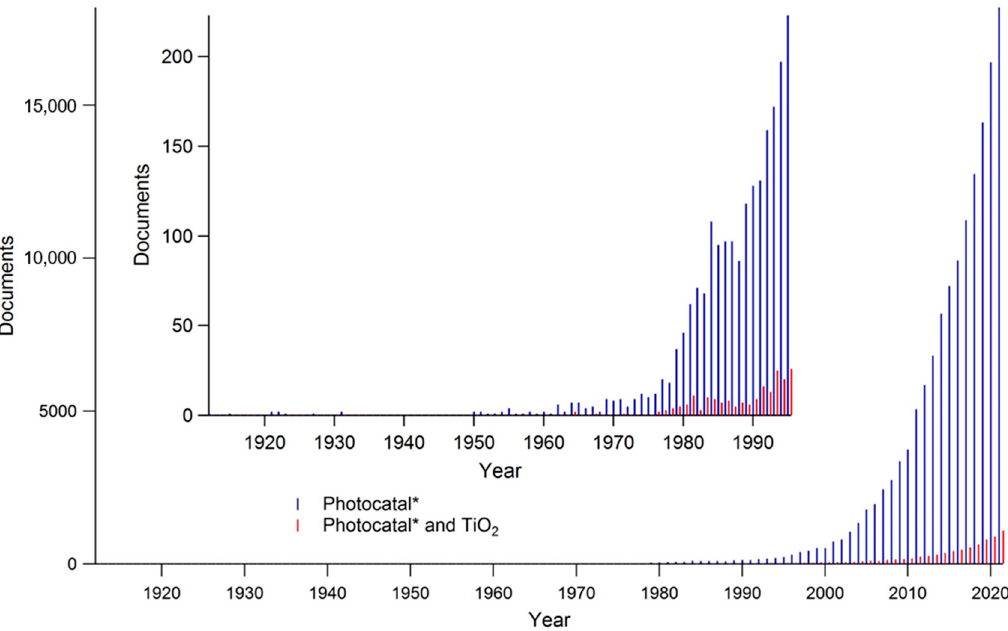
Figure 1. Number of published documents (database: Scopus, 20 September 2022) per year indexed as “ photocatal* ” and “ photocatal* and TiO 2 ”. Insert: zoom from 1912 to 1995.